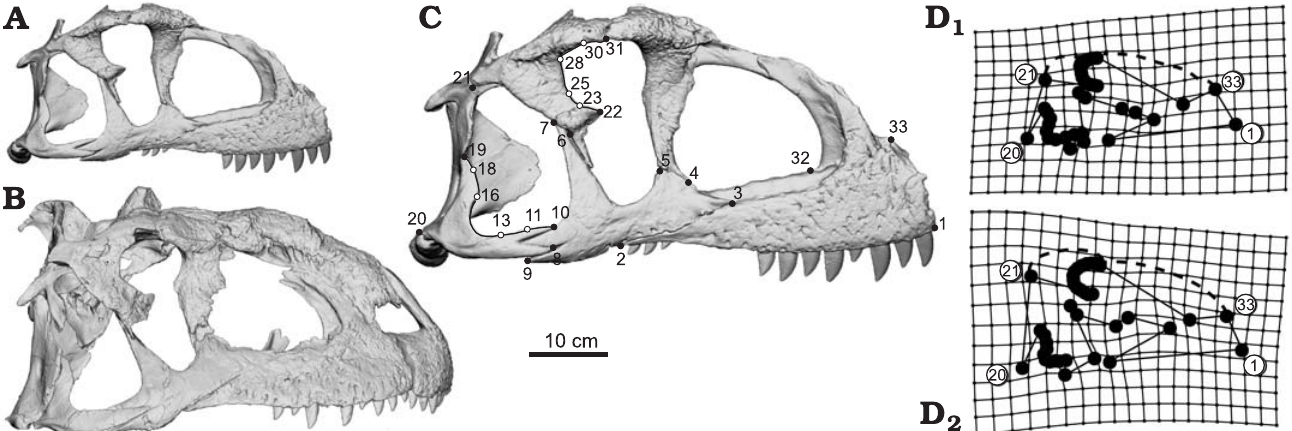
Fig. 1. Whole (B) and partial (A) skulls (rendered CT images) of Majungasaurus crenatissimus (Depéret, 1896) Lavocat, 1955 from the Maastrichtian (Late Cretaceous) Maevarano Formation, northwestern Madagascar in left lateral view. A . UA 9944. B . FMNH PR 2100. C . Illustration of landmark positions used for articulated skull. Black circles, landmarks; white circles interconnected with solid lines, semilandmarks. D . Ontogenetic shape change visualized by deformation grids for 2D data (see Bhullar et al. 2012); outline of smallest (D 1 ) and largest (D 2 ) specimens from